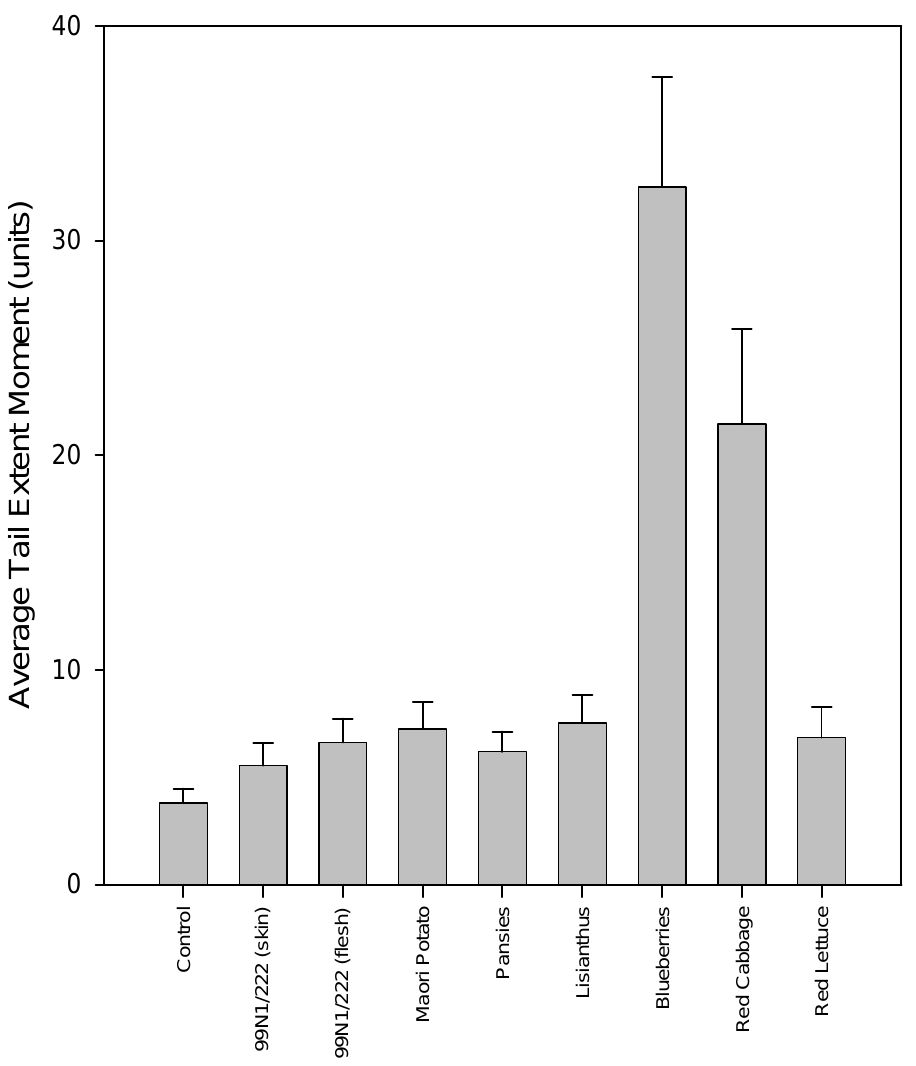
O at 37 o C 2 2